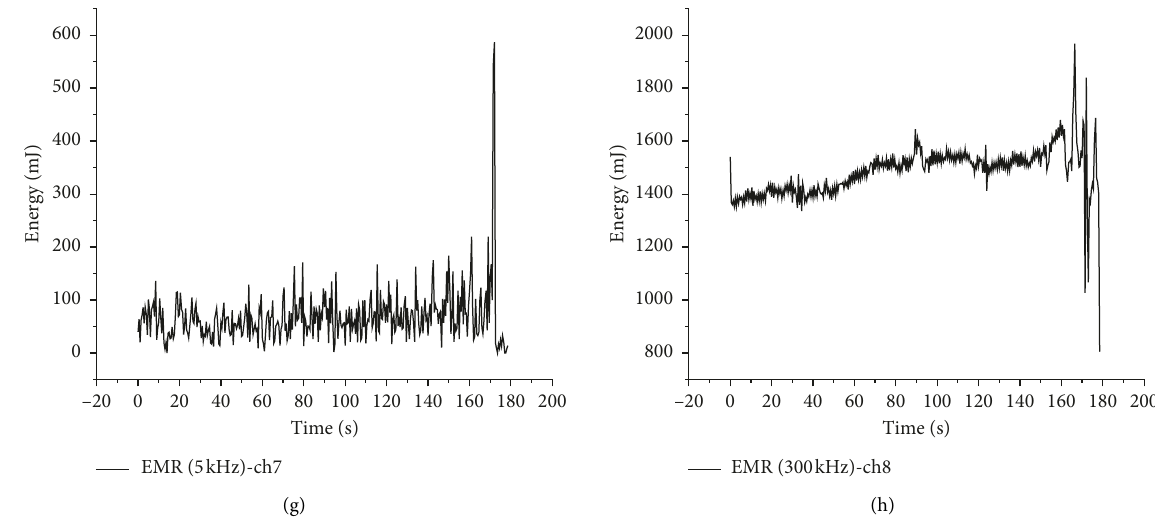
Figure 4: Electric-magnetic-acoustic signals of 1# rock sample (1 mm/min). (a) Stress-time. Electric signals of (b) ch2, (c) ch8, and (d) ch9. (e) Acoustic emission signals. Magnetic signals of (f) ch5, (g) ch7, and (h)